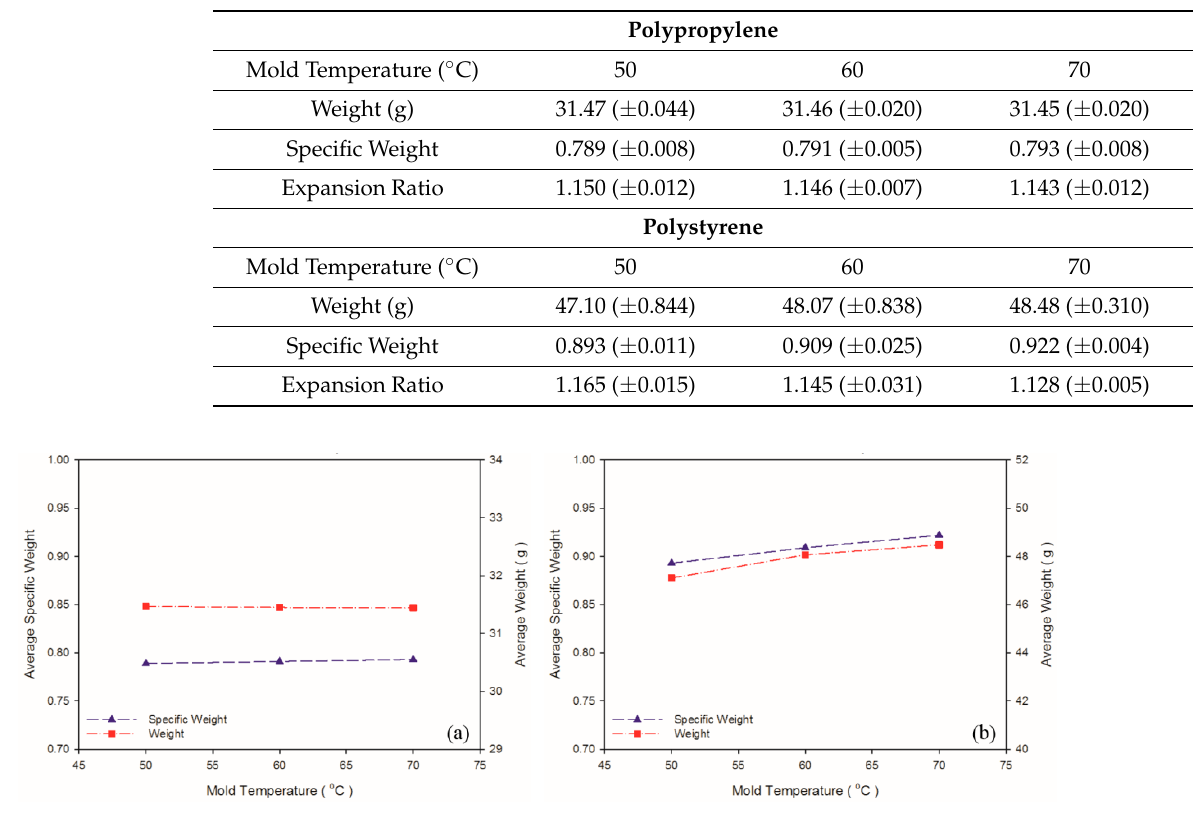
Figure 12. Weight and specific weight at different mold temperatures: ( a ) PP matrix and AC CBA; ( b ) PS matrix and AC CBA.